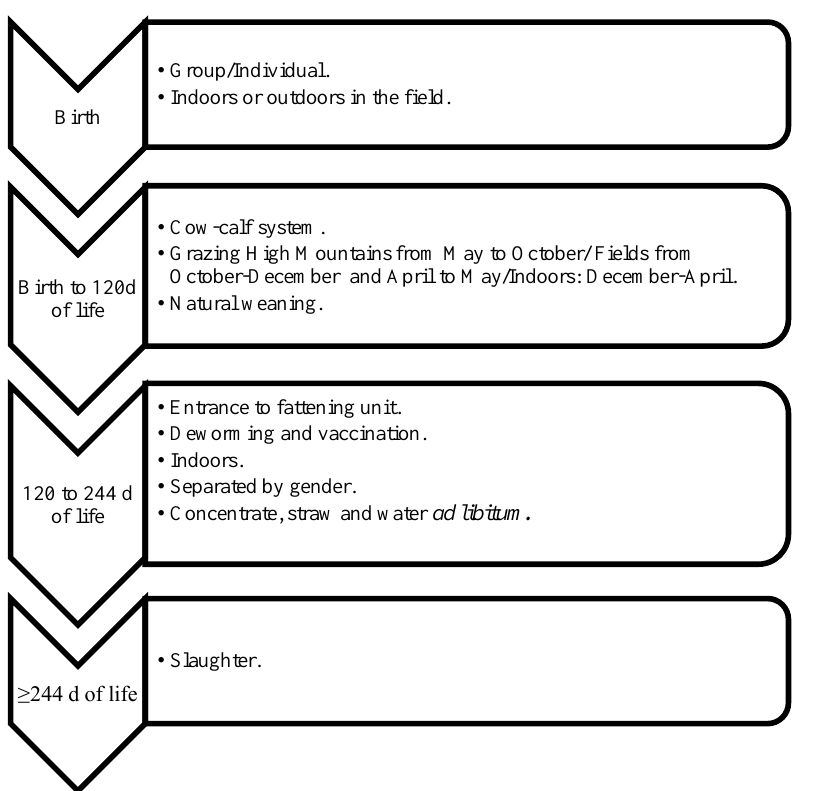
Figure 3. Management, nutritional, and husbandry protocols used during the calf-rearing process of Bruna d’Andorra Bovine Breed (BA) and Bruna d’Andorra × Limousin (BA × L) males and females destined for fattening.